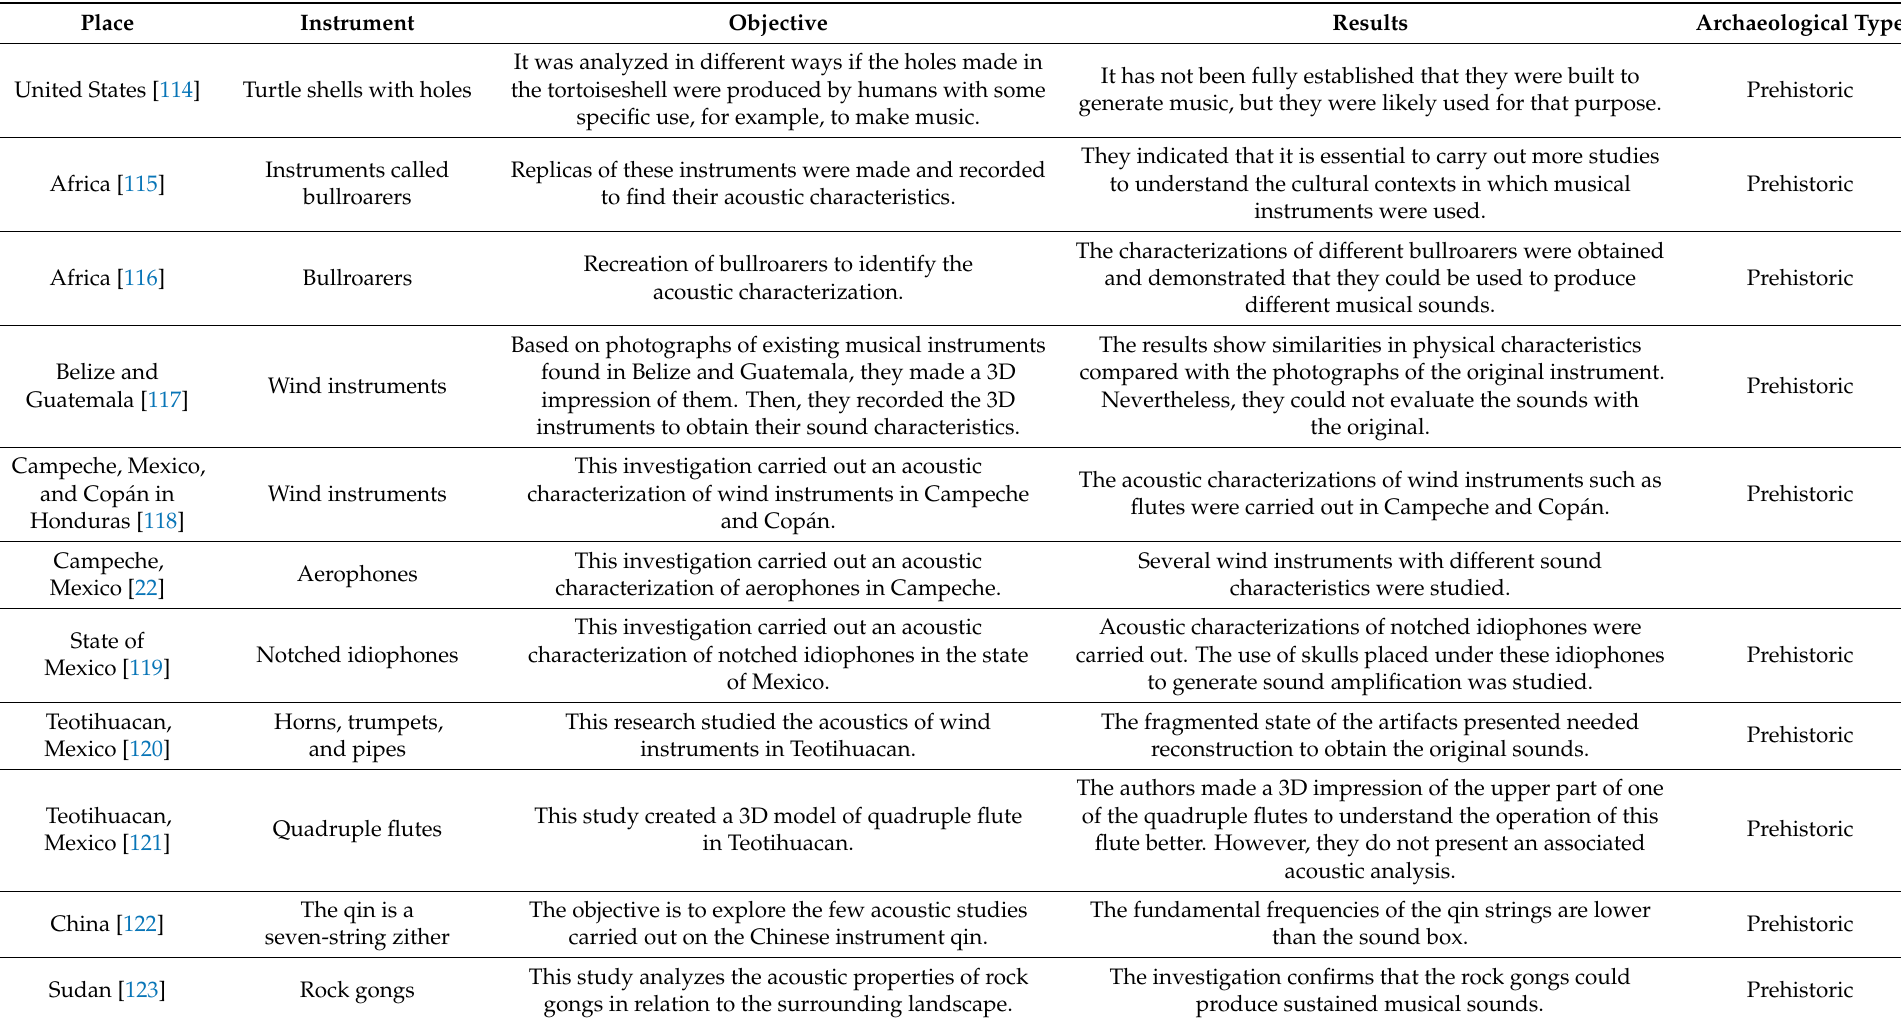
Table 5. Systems and procedures used in musical instruments and pieces studies